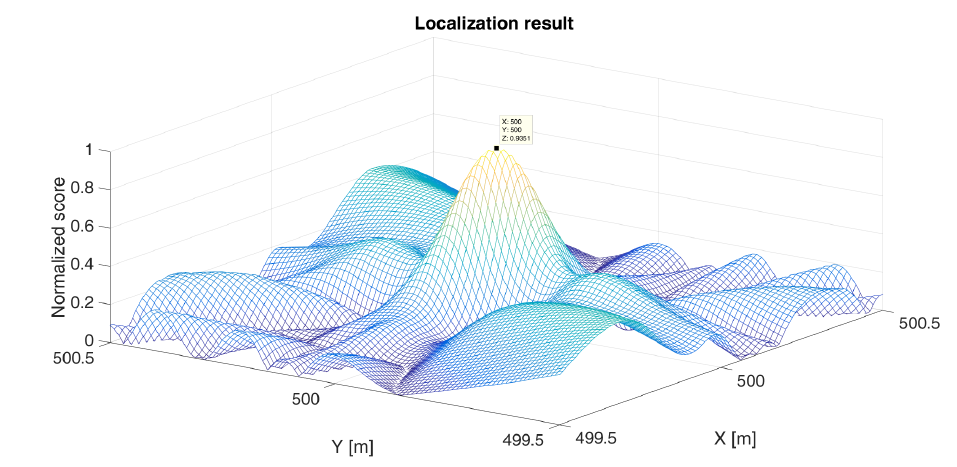
Figure 7. The localization results within narrowed search zones around acoustic source.